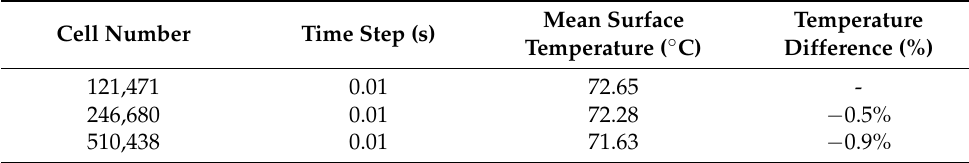
Table 4. Analysis of grid independence.